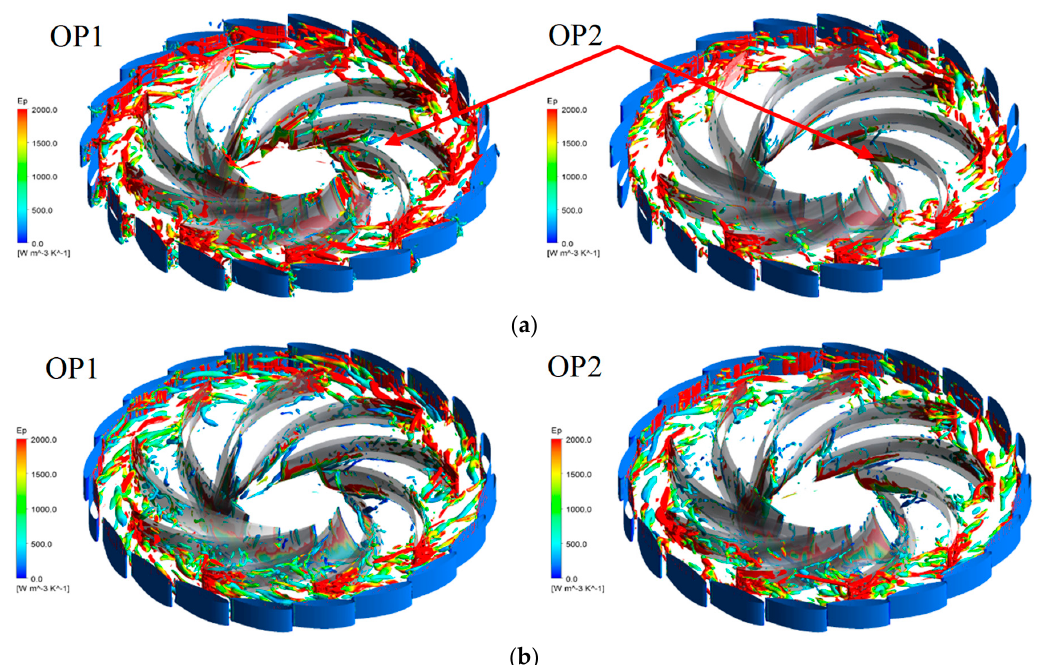
Figure 14. Vortex structures in the flow passages at no-load points OP1 and OP2; ( a ) 15° GVO; ( b ) 6° GVO.